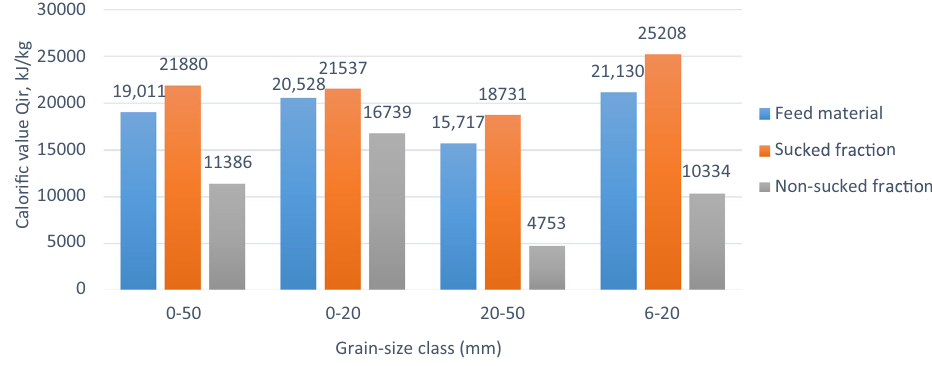
Fig. 9 Calorific value of each fraction for different grain-size classes (feed material No. 1)